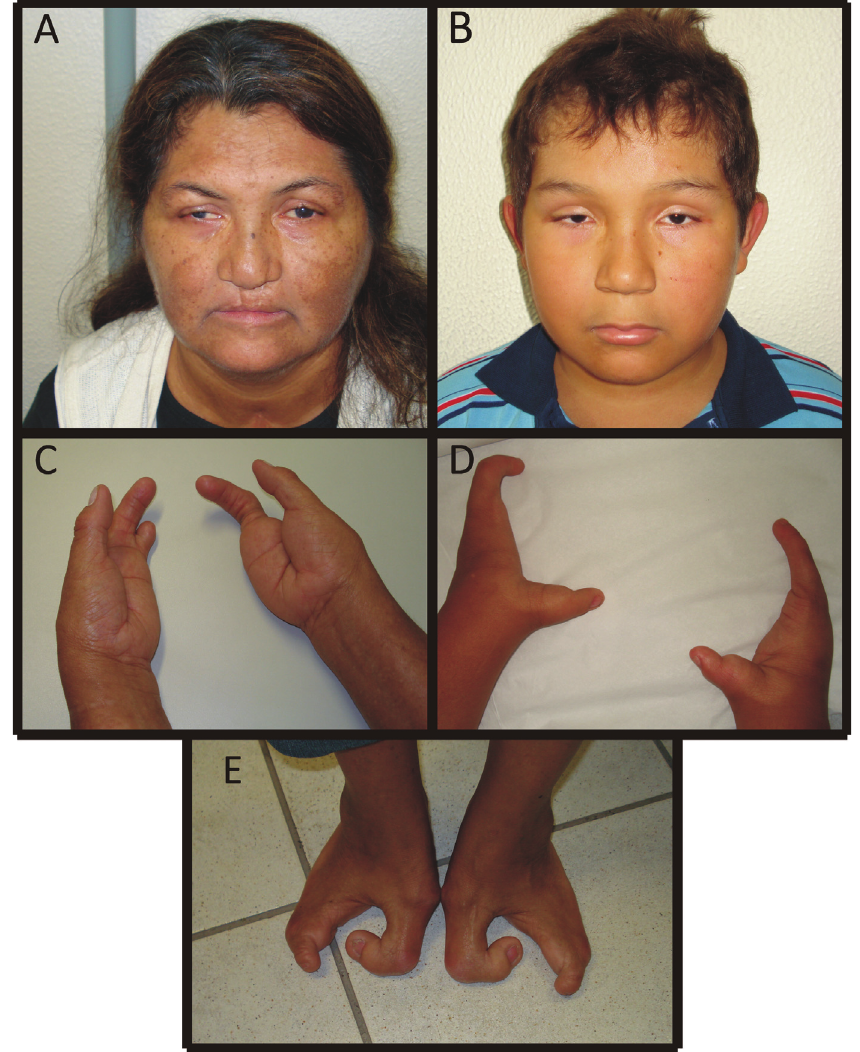
Figure 2 - Images showing split-hand/foot malformation (SHFM) in patients investigated. (A) proband; (B) proband’s son; (C) hands of proband; (D) hands of proband’s son; (E) feet of